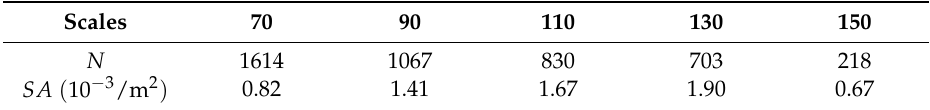
Table 4. Geoscene-segmentation accuracies at five scales, with N referring to the number of geoscenes and SA representing the segmentation